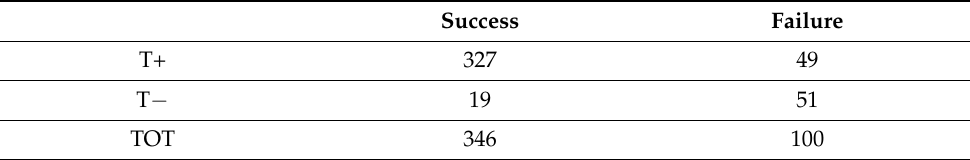
Table 2. Decision-making matrix (attended outcome: T+ or T − ; real outcome: success or failure). Success Failure T+ 327 T −